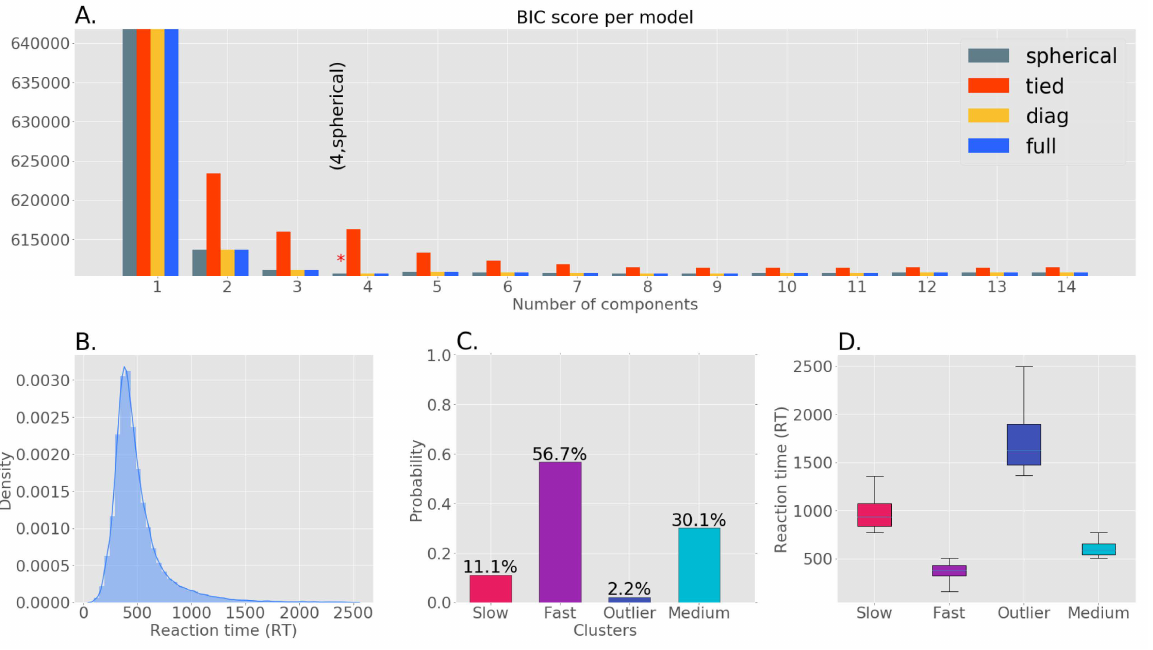
Figure 1. Clustering of RT data. ( A ) Bayesian Information Criterion (BIC) scores of models with different numbers of components and covariance types, the ‘*’ denotes the model with the lowest BIC score. ( B ) Original RT distribution. ( C ) The probability of each RT cluster using the GMM with the lowest BIC score. ( D ) The RT range of each cluster (slow: 772–1360 ms, fast: 100–504 ms, outlier: 1364–2500 ms, medium: 506–770